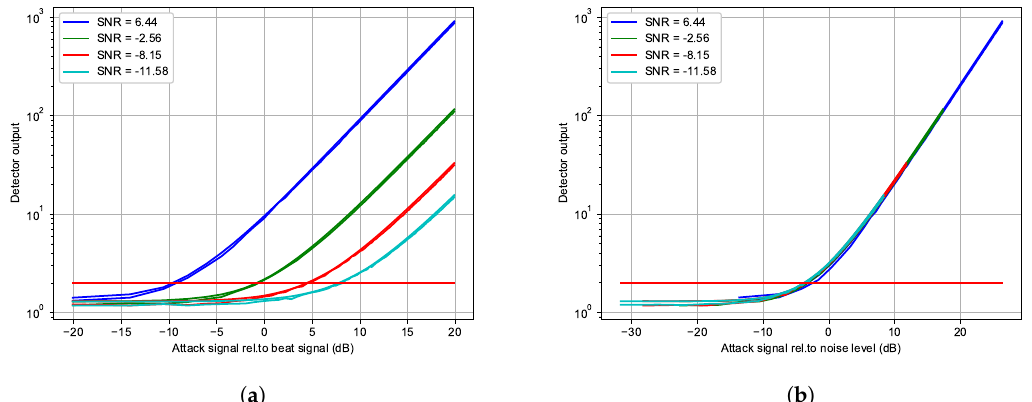
Figure 14. Test case eTX1. The horizontal orange colored line is the detection threshold. In ( a ) with respect to the beat signal level, and in ( b ) with respect to the noise